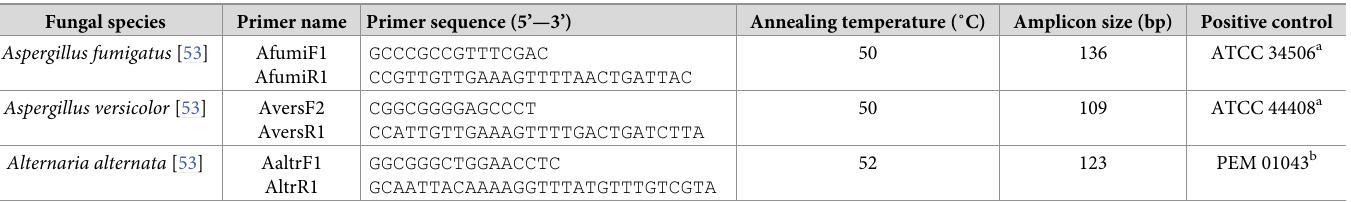
Table 2. PCR primers